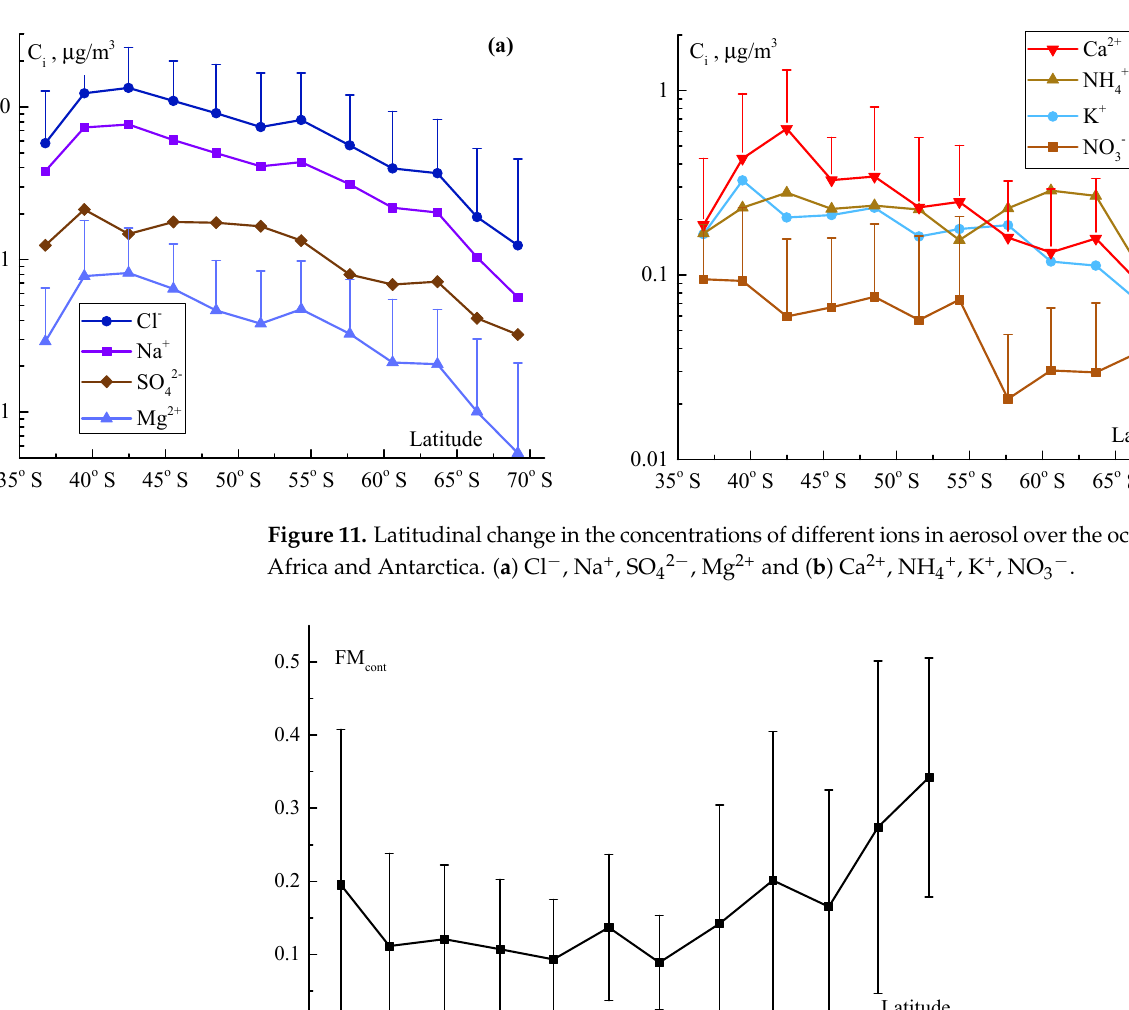
Table 2. Average values and standard deviations (±SD) of water-soluble ion concentrations (µg/m 3 ). Latitude